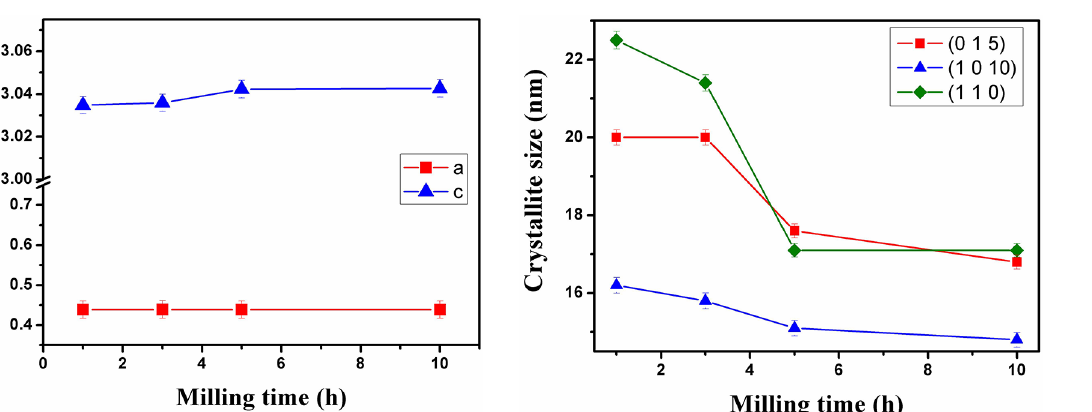
Figure 3. Variation of lattice parameters of Bi increasing milling time. Table 2. Microstructure parameters of unmilled and ball milled Bi Milling time